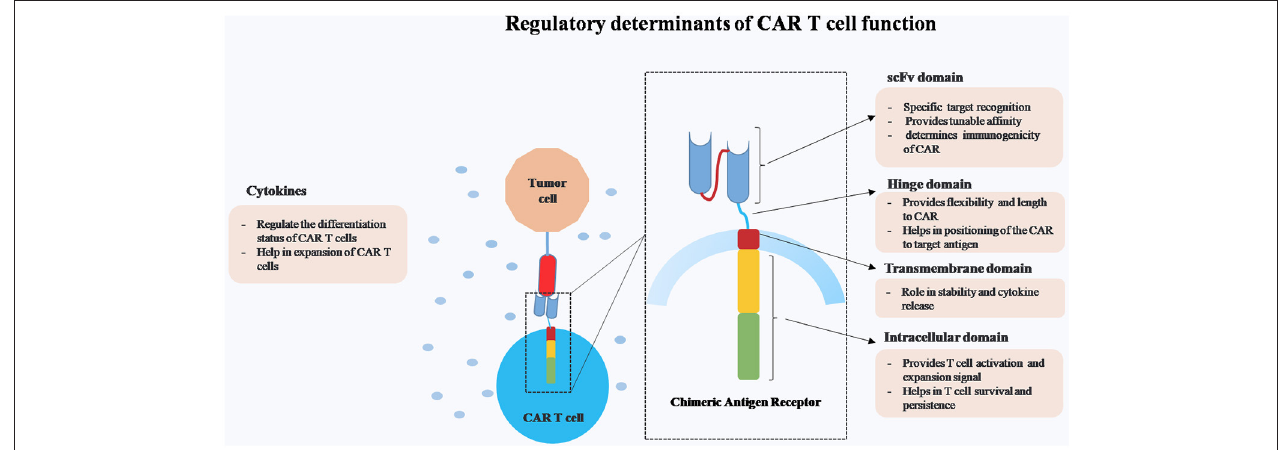
FIGURE 1 | Schematic representation of different regulatory components of Chimeric Antigen Receptor (CAR) T cells.